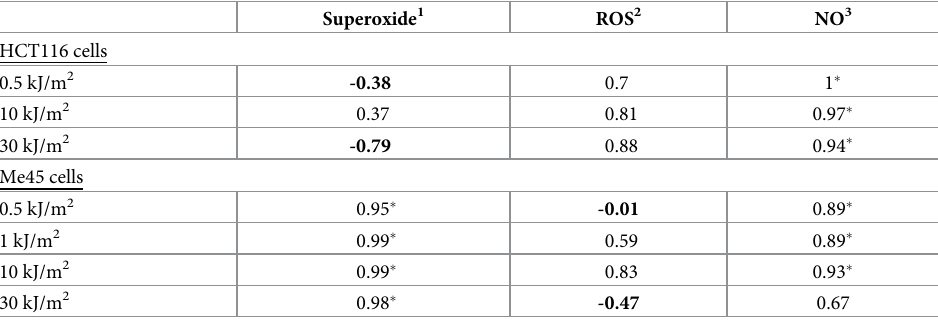
Table 1. Correlation coefficients for the degree of similarity between radical dynamics in UV-irradiated vs. con- trol